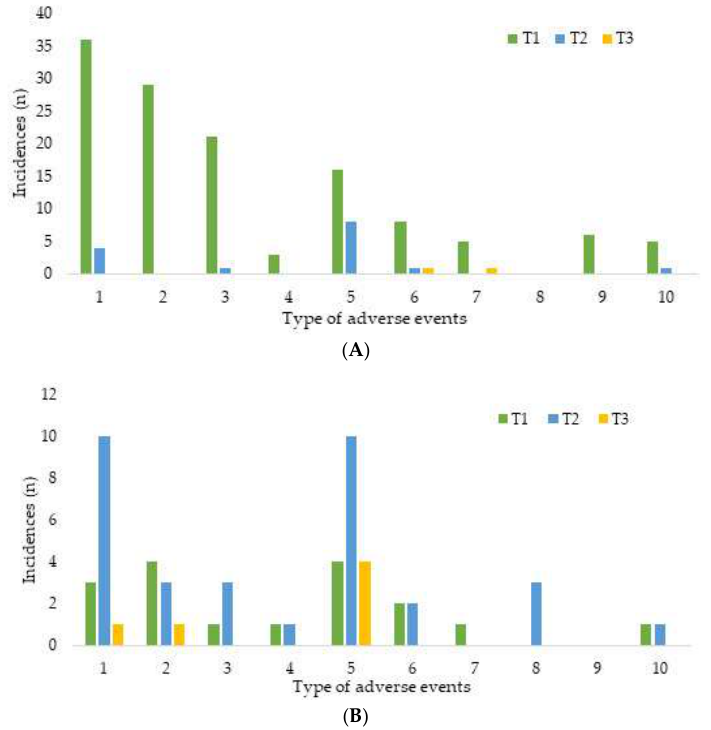
Figure 2. Distribution of adverse event types in ( A ) group I and ( B ) group O. 1: dizziness or headache; 2: drowsiness; 3: blurred or double vision; 4: unusual smell; 5: nausea or vomiting; 6: skin